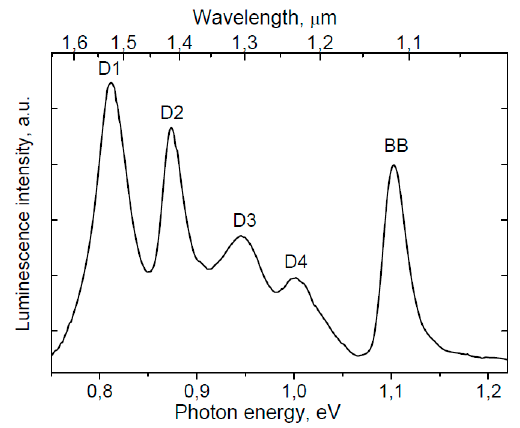
Figure 20. Luminescence spectrum, taken at 80 K, obtained from a plastically deformed silicon sample showing the dislocation lines (D1–D4) and band-to-band (BB) radiation.